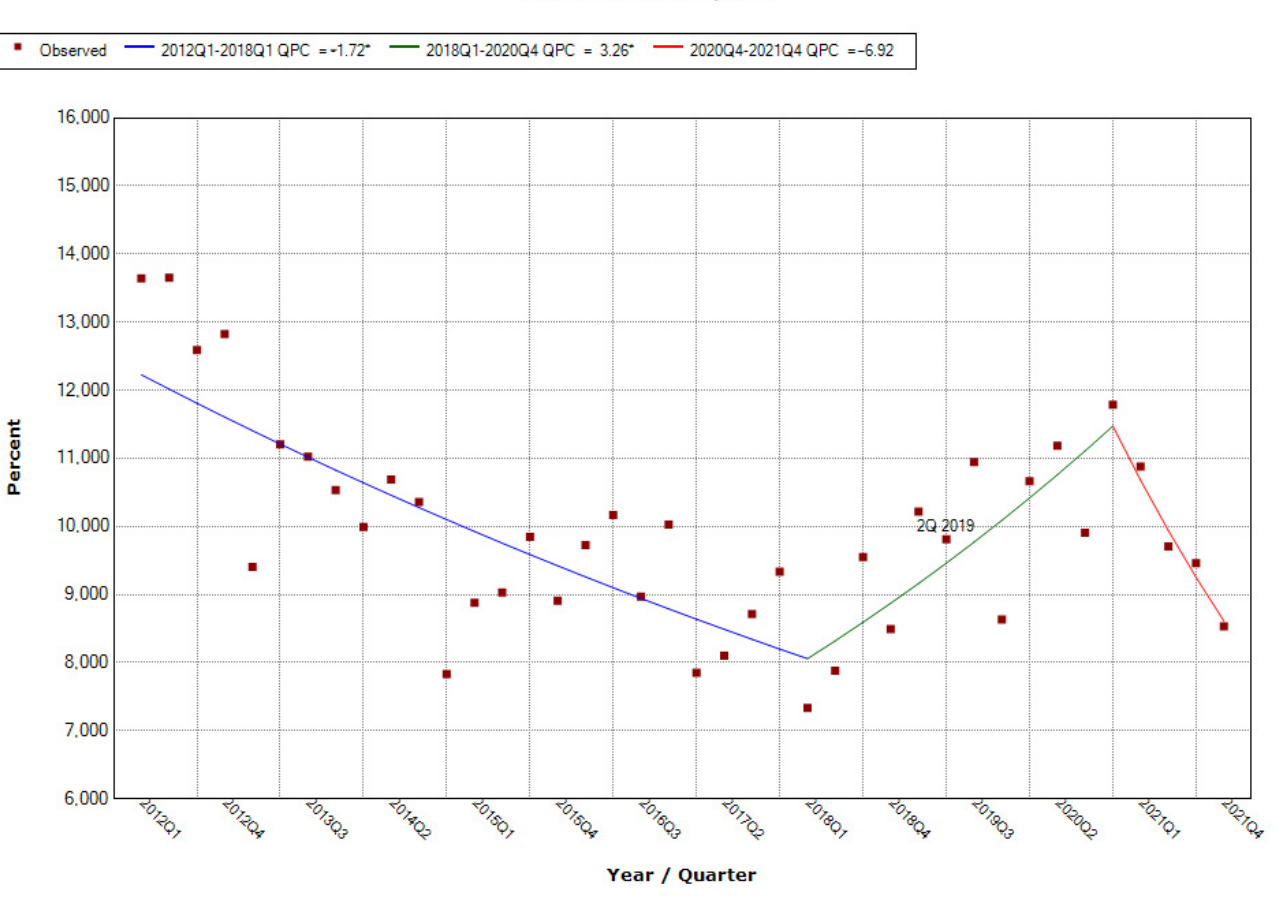
Figure A30. Percentage of products containing folic acid in individual quarters in the period from 2012 to 28 November 2021. Joinpoints mark trend turning points. The date above the observation indicates the moment of publication of the scientific opinion/resolution.